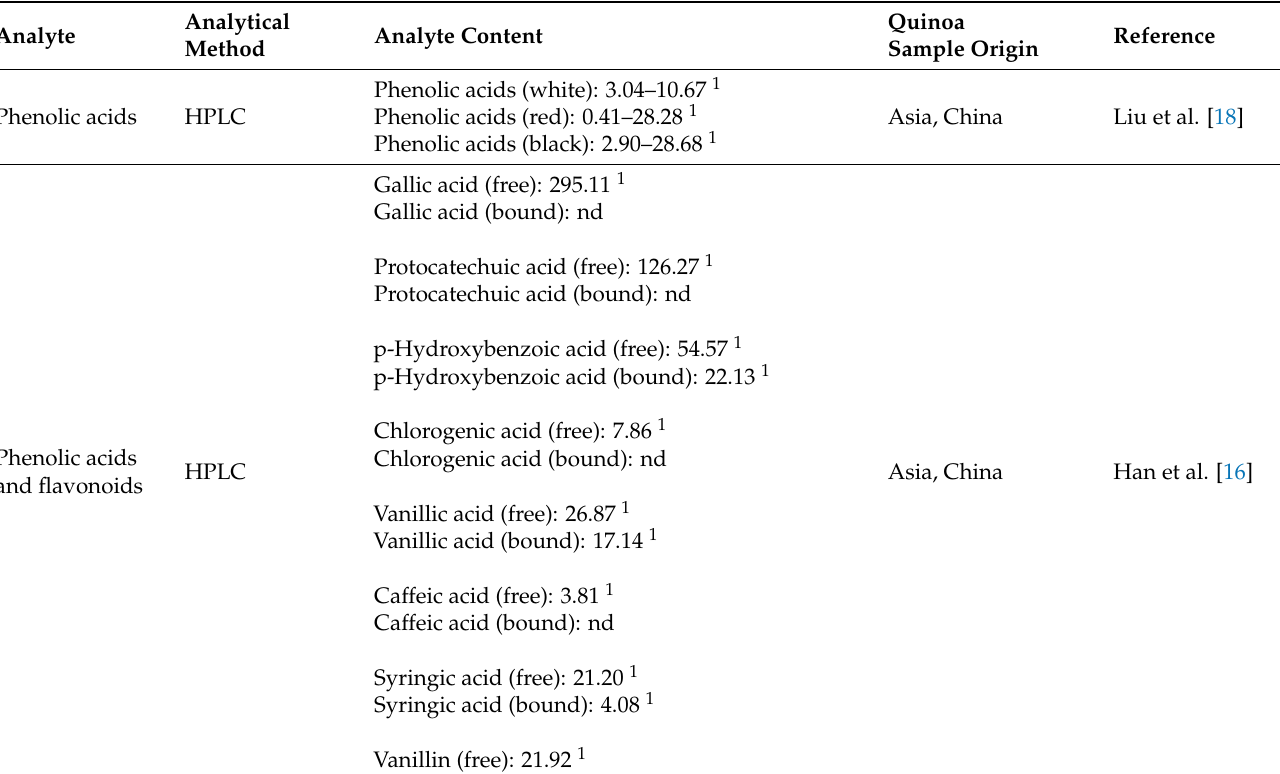
Table 3. Phenolic compound profile in quinoa